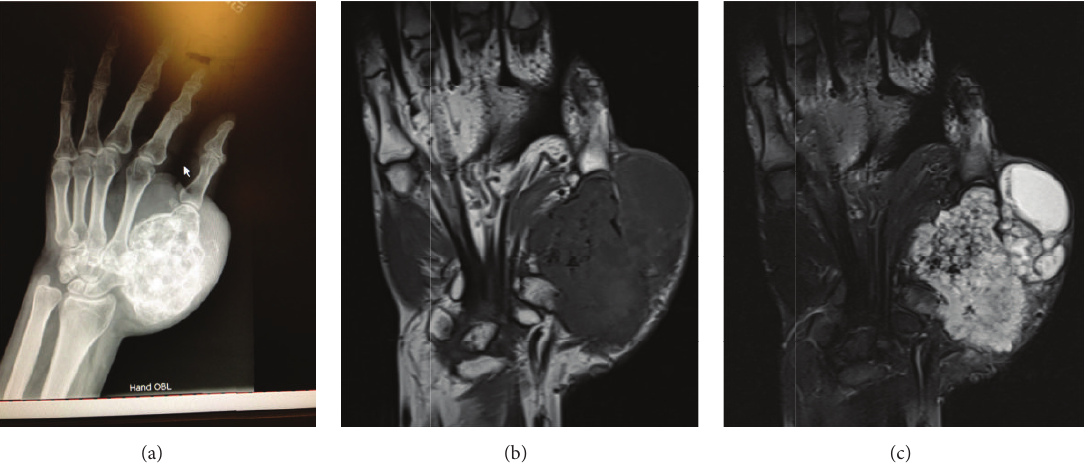
Figure 2: Preoperative imaging. (a) X-rays demonstrating a large, calcified tumor arising from the first metacarpal. (b) Coronal T1-weighted MRI of the left hand. (c) Coronal T2-weighted MRI of the left